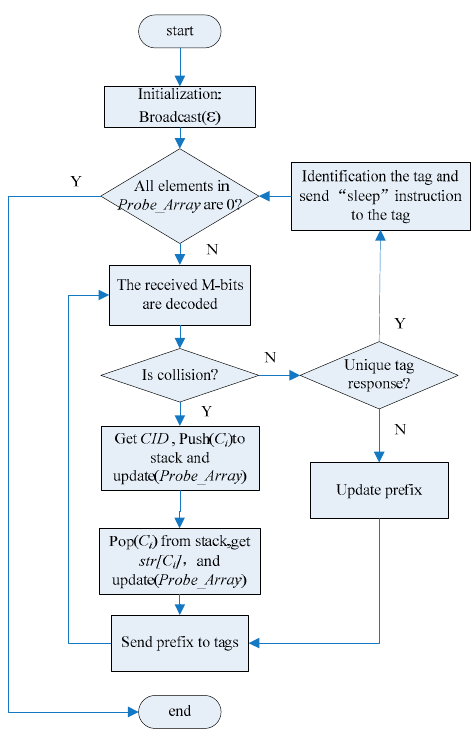
Figure 6. Algorithm flow chart of reader side.